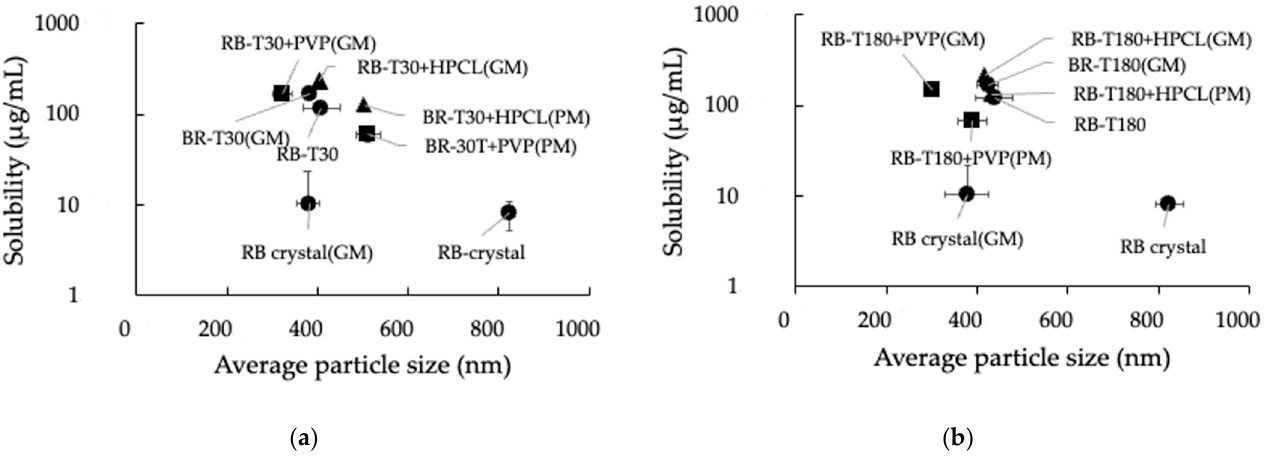
Figure 6. Solubility of rebamipide at various average particle sizes: ( a ) RB − T30 and ( b ) RB − T180.